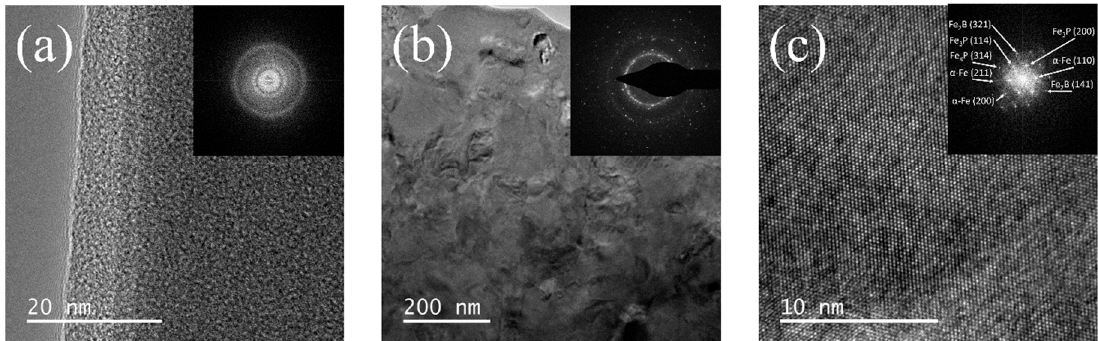
Figure 5. TEM micrographs of Fe 76 Si 9 B 10 P 5 ( a ) in the as-spun state, ( b ) annealed at 813 K, and ( c ) 1073 K. The samples were annealed at different temperatures using the NETZSCH DSC 404C for 60 s. (Figure 5c insert is given in Supplementary file for better clarity)